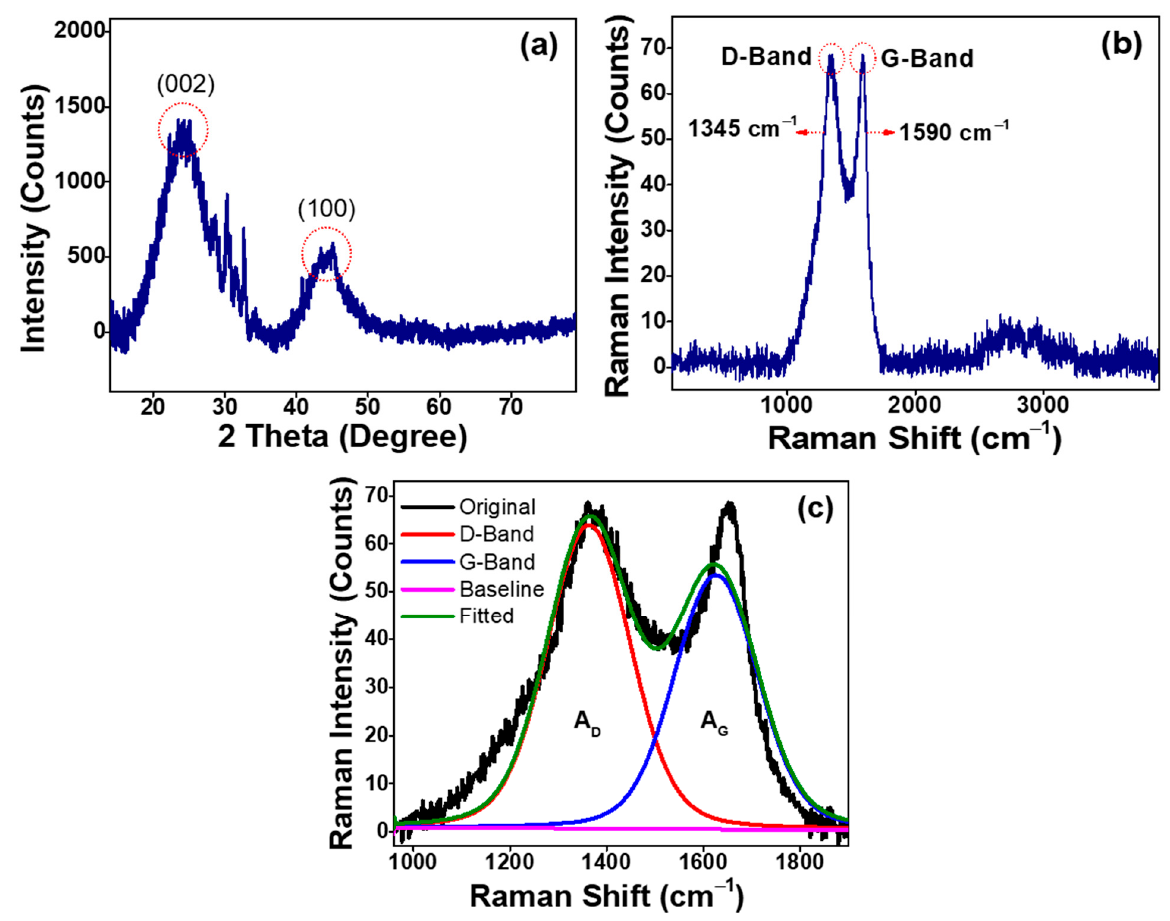
Figure 3. ( a ) XRD pattern, ( b ) Raman spectrum, and ( c ) Raman spectrum with area deconvolution of the prepared ATC.